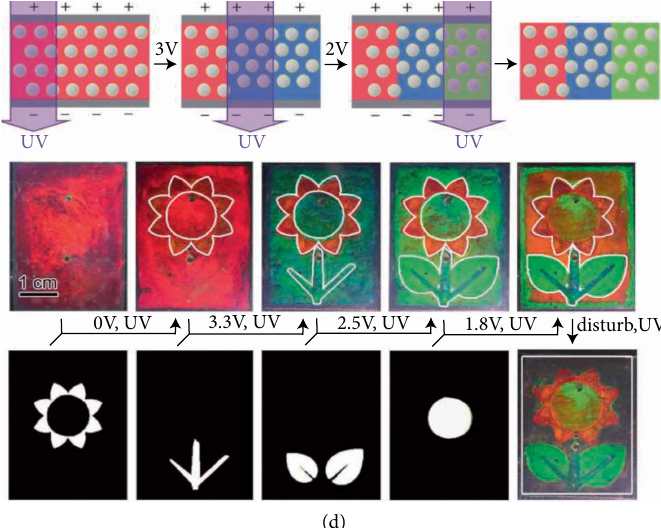
Figure 5: (a) Cross-linking SEM images, photographs, and their corresponding reflective spectra. Adapted from [164]. (b) Optical image of the RPC-based barcode film at the dried state and after smeared with deionized water. Adapted from [166]. (c) Photolithography with an amorphous silicon photomask on a glass wafer enabled the patterning of small K’s with different colours by angle and its application on a Korean bank note. Adapted from [165]. (d) Lithographical printing of multicolour flower by periodically photomask covering, electric field tuning, and UV curing. Adapted from